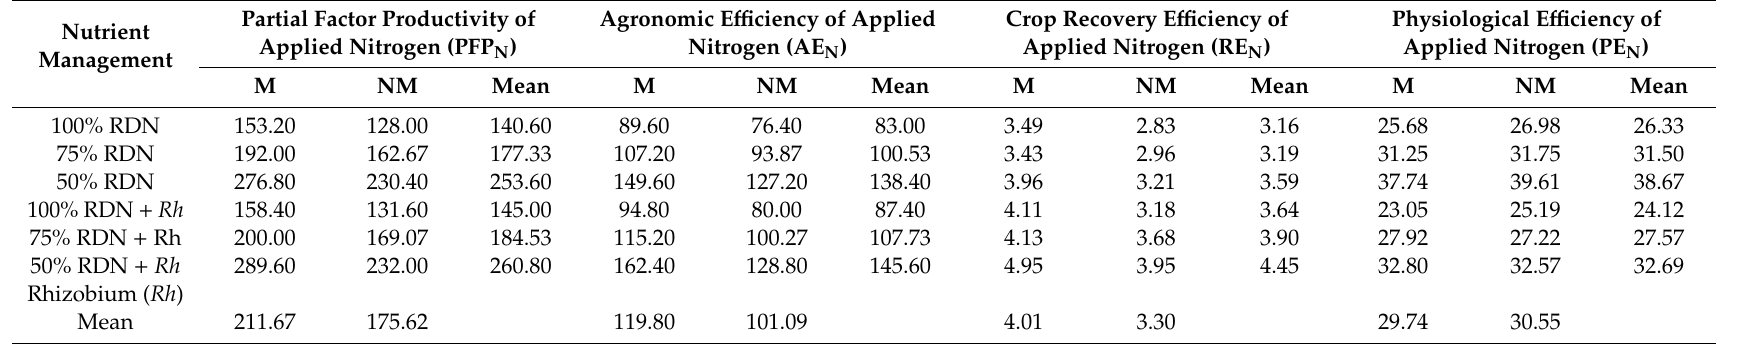
Table 7. E ff ect of soil covering and nutrient management on PFPN, AEN, REN and PEN of peanut in 2015–2016.